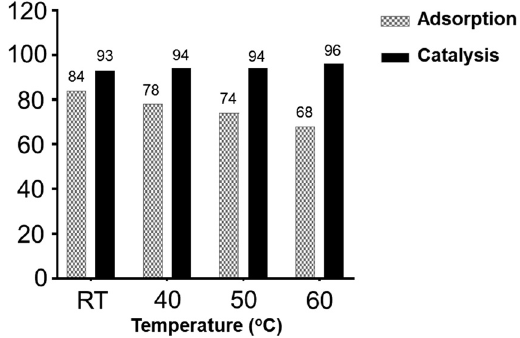
Figure 5: E ff ect of temperature on the DBF removal e ffi ciency. Catalysis: [ DBF ] = 30 ppm, [ H 2 O 2 ] = 15 mM, catalyst dosage = 10 mg, time = 60min. Adsorption: [ DBF ] = 30ppm, adsorbent dosage = 10mg, time =